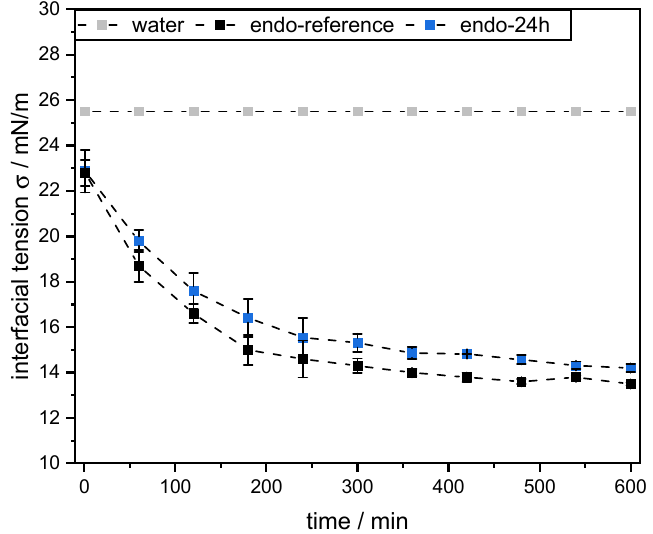
Figure 5. The mct oil–water interfacial tension, using 0.1 wt% pectin solutions with and without enzymatic modification (24 h enzymatic treatment using endo -polygalacturonanase), measured over time at 25 ◦ C. As a reference, the interfacial tension was measured without the addition of pectin.